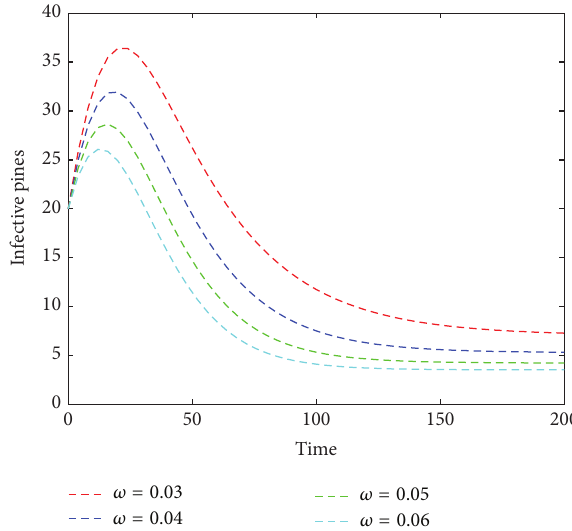
Figure 3: The effect of 𝜔 on infected pine trees for Π ℎ = 0.22 , Π V = = 0.002 , 𝜔 = 0.03, 0.04, 0.05, 0.06 , 𝜇 0.32 , 𝜇 = 0.004 , 𝛽 = 0.0004 , 𝛽 = 0.00034 , 𝛿 = ℎ V 1 2 1 = 0.00034 , 𝛿 = 0.0016 , 𝛿 = 0.00016 , 𝜃 = 0.00301 , 𝛼 𝛽 = 0.001 , and 𝛼 = 0.001 . 2 1 2 1 2 and 𝛼 2 = 0.001 .